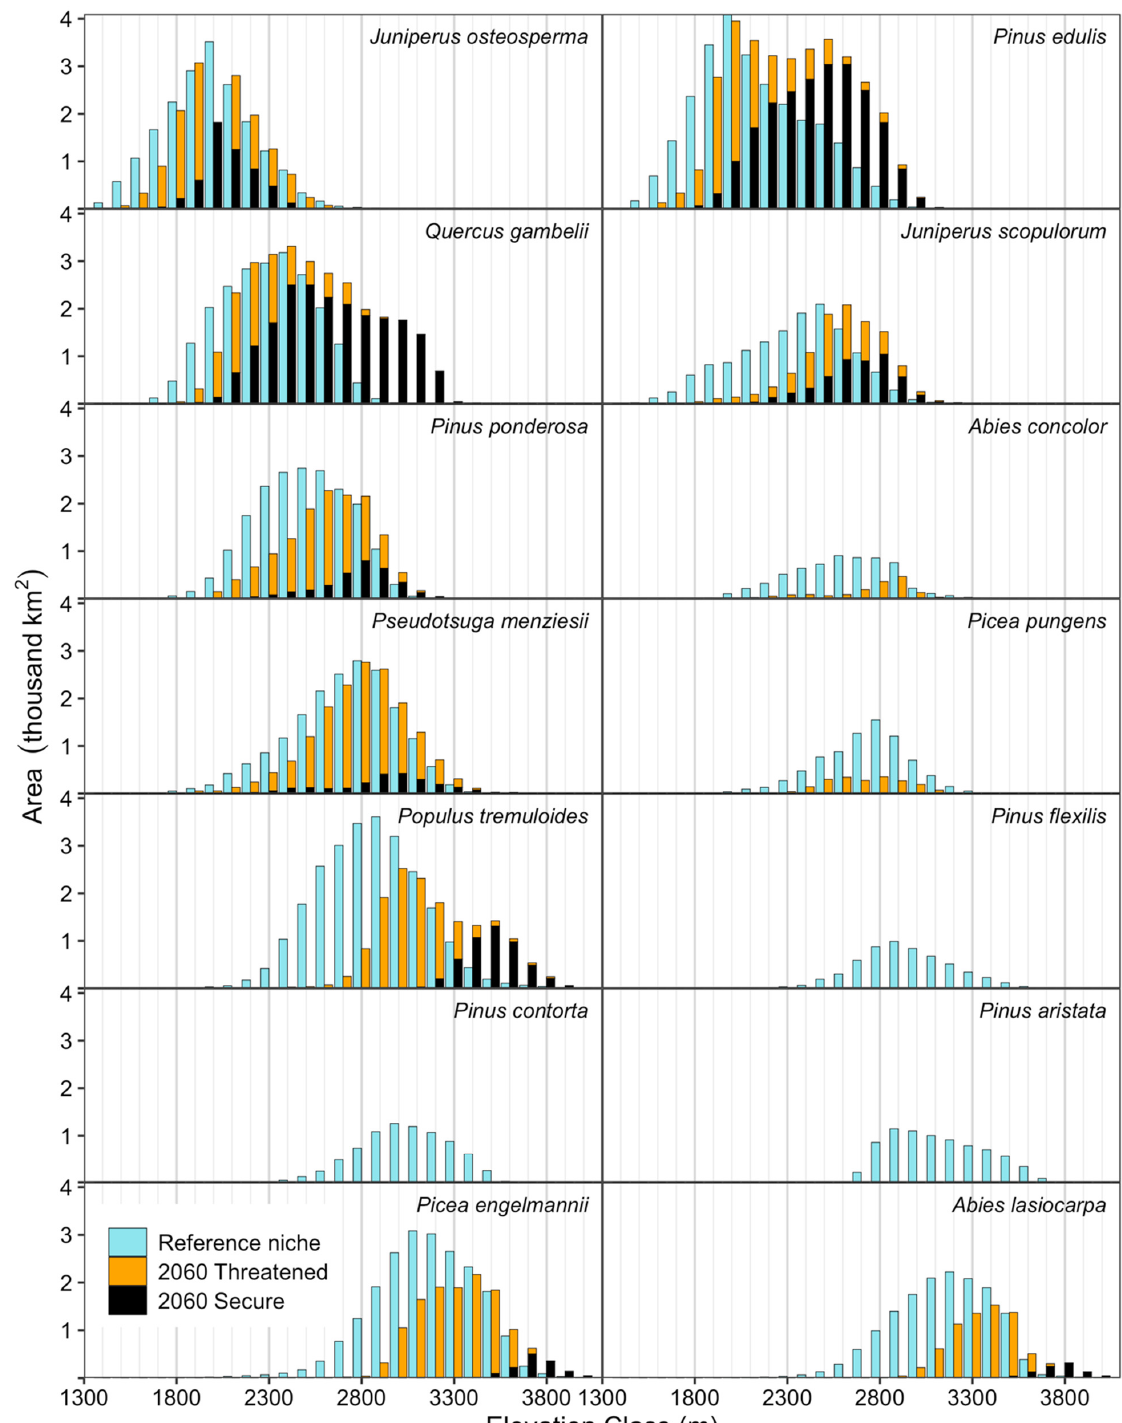
Figure 3. Modeled niche area of species by elevation in reference period and the decade around 2060. Each 100 m elevation class is represented by two columns, one for the reference period and one for 2060. The latter represents the optimistic niche area including threatened habitat (orange); the black portion is the secure niche area, with only persistent and emergent.